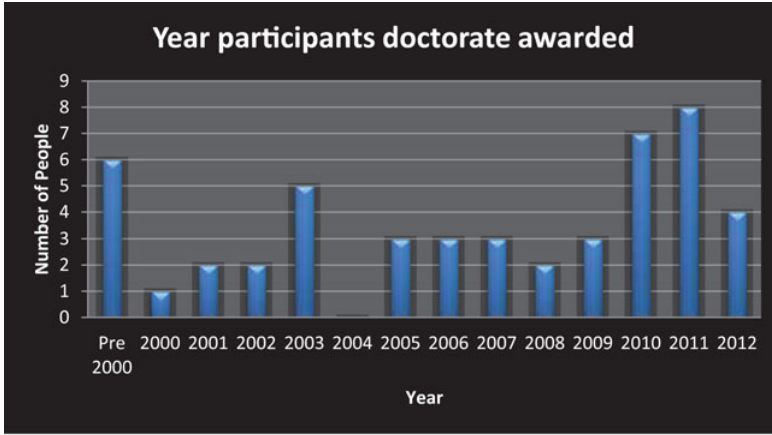
(Colour online) Year doctorate was